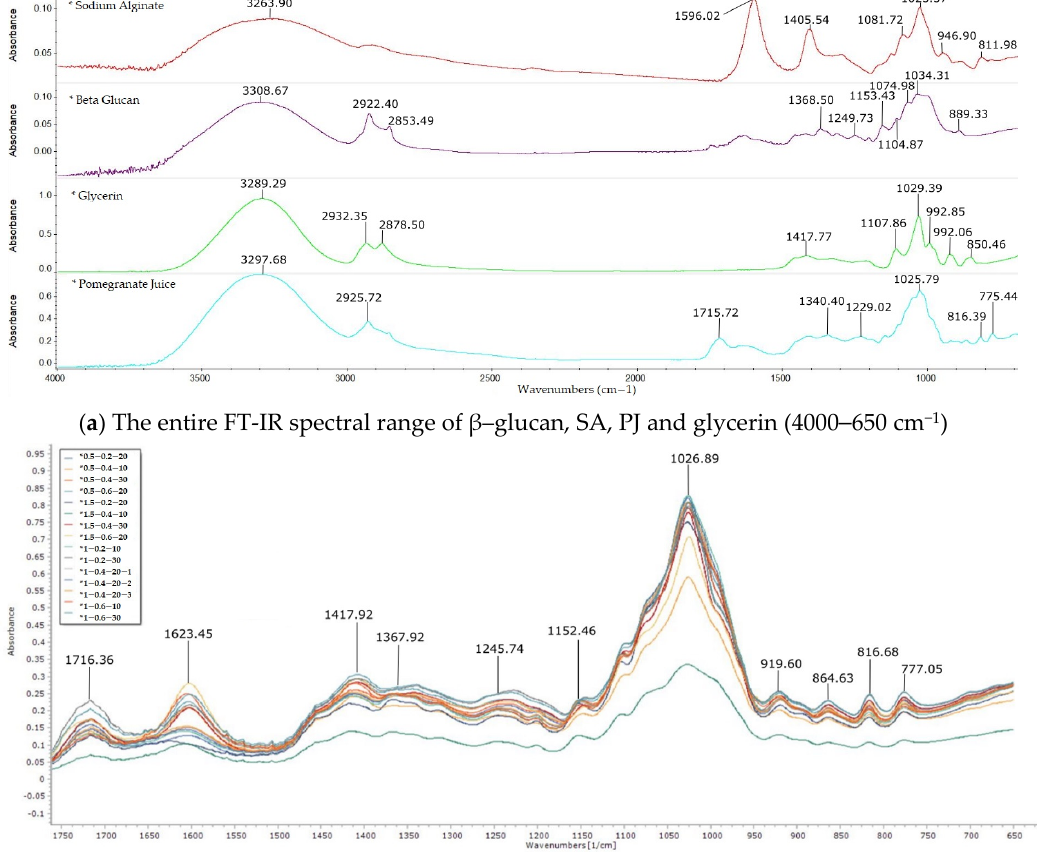
Figure 4. FT-IR spectra: ( a ) Spectra of β –glucan, sodium alginate, pomegranate juice and glycerin before the films were produced (4000–650 cm − 1 ); ( b )FT-IR spectra of the film samples (1800–650 cm − 1 ).